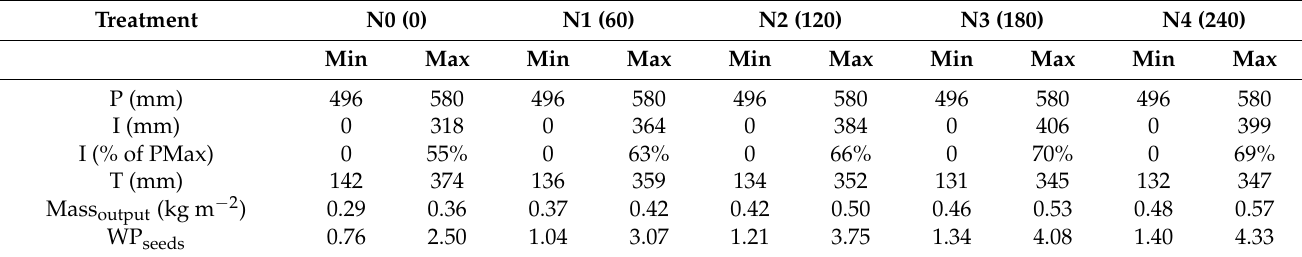
Table 4. Minimum and maximum estimates of mean fluxes, mass output, and water productivity for the five fertilization treatments N0–N4 (kg N ha − 1 a − 1 ) in the years 2013–2015, including all errors from the experimental results. I, evaporation from interception; T, transpiration; Mass output , seed yield; P, precipitation; W input , water input; WP seeds , water productivity seeds. Mass output (kg m − 2